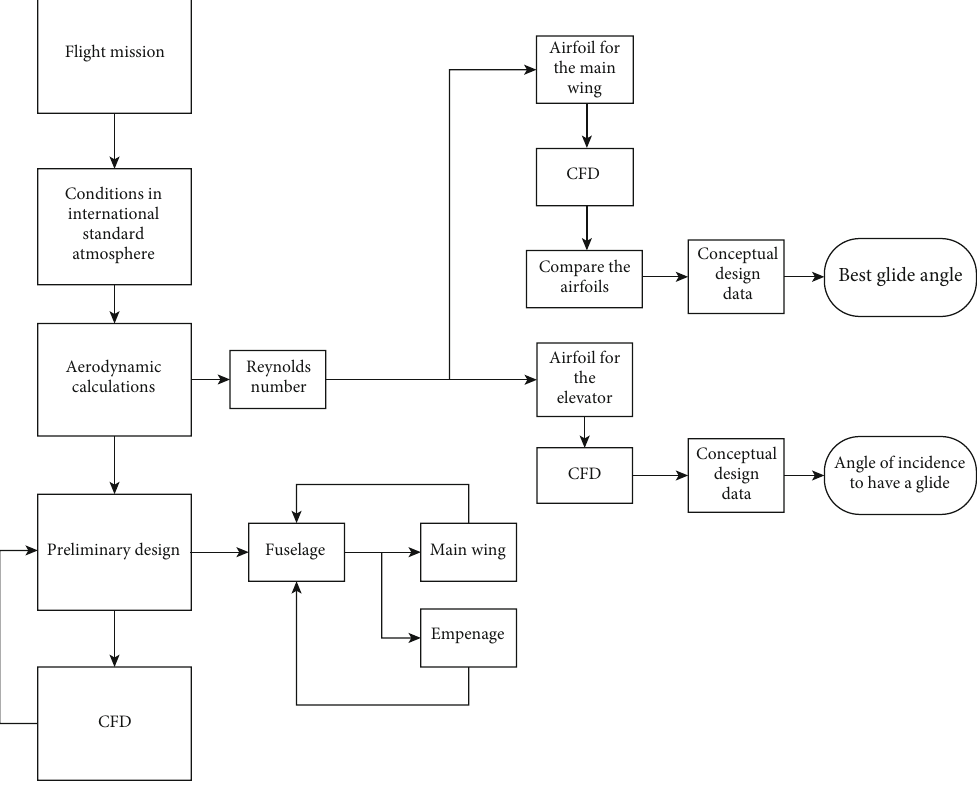
Figure 1: Flow chart of the design of a UAV using alternative